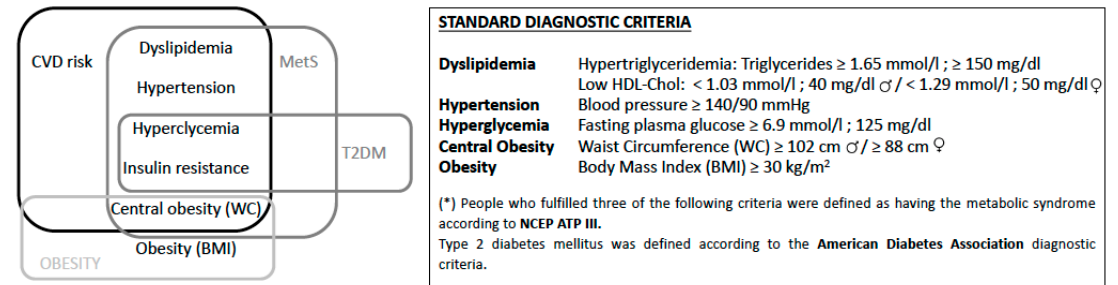
Figure 1. Summary of cardiodiabesity and standard diagnostic criteria. Cardiodiabesity encompasses cardiovascular disease (CVD), type 2 diabetes mellitus (T2DM), metabolic syndrome (MetS), and obesity. Note: Reproduced with permission from García-Fernández et al. [6]. Abbreviations not previously defined: HDL-Chol, high-density lipoprotein cholesterol.